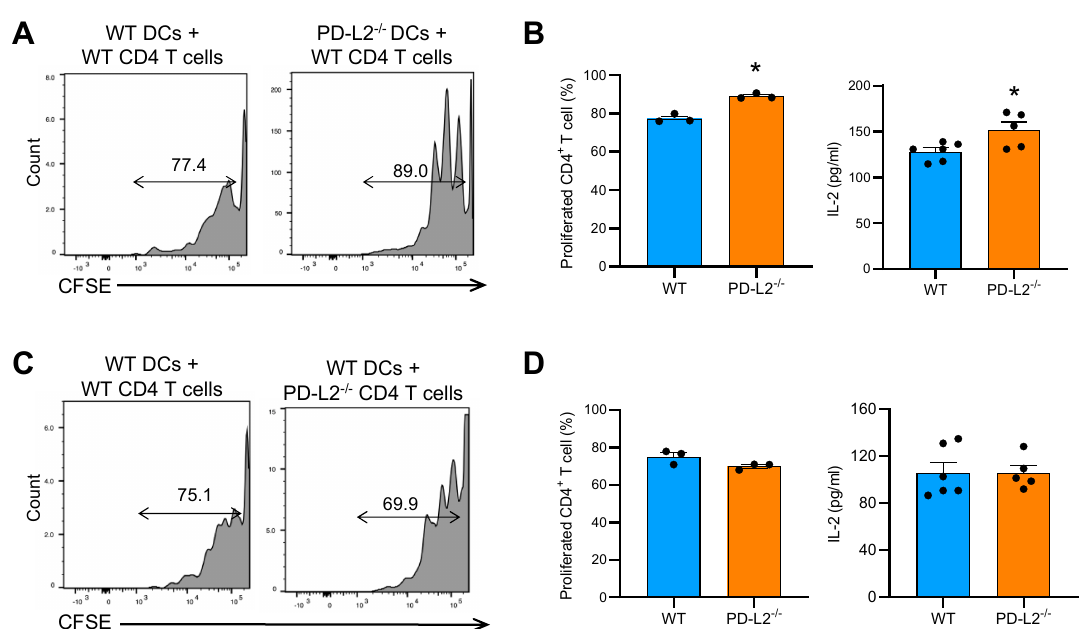
Figure 6. PD-L2 deficiency in dendritic cells (DCs) promoted CD4 + T cell proliferation. ( A , B ) Carboxyfluorescein succin- imidyl ester (CFSE)-labeled WT CD4 + T cells were co-cultured with bone marrow-derived dendritic cells (BMDCs) generated from wild-type (WT) or PD-L2 − / − mice and stimulated with anti-CD3 and anti-CD28 for 72 h. Proliferation of CD4 + T cells was visualized by observing the incremental loss of CFSE fluorescence. Representative histograms (gated on CD4 + T cells) and the frequency of the proliferated CD4 + T cells among all CD4 + cells are shown. n = 3 per group. IL-2 concentrations in the culture supernatants were assessed by ELISA. n = 6 per group. Results are presented as the mean ± SEM. * p < 0.05 vs. WT. ( C , D ) CD4 + T cells were isolated from WT or PD-L2 − / − mice and labeled with CFSE. Then, they were co-cultured with WT BMDCs and stimulated with anti-CD3 and anti-CD28 for 72 h. Proliferation of CD4 + T cells was visualized by observing the incremental loss of CFSE fluorescence. Representative histograms and the frequency of the proliferated CD4 + T cells among all CD4 + cells are shown. n = 3 per group. IL-2 concentrations in the culture supernatants were assessed by enzyme-linked immunosorbent assay. n = 6 per group. Results are presented as the mean ± standard error of the mean.